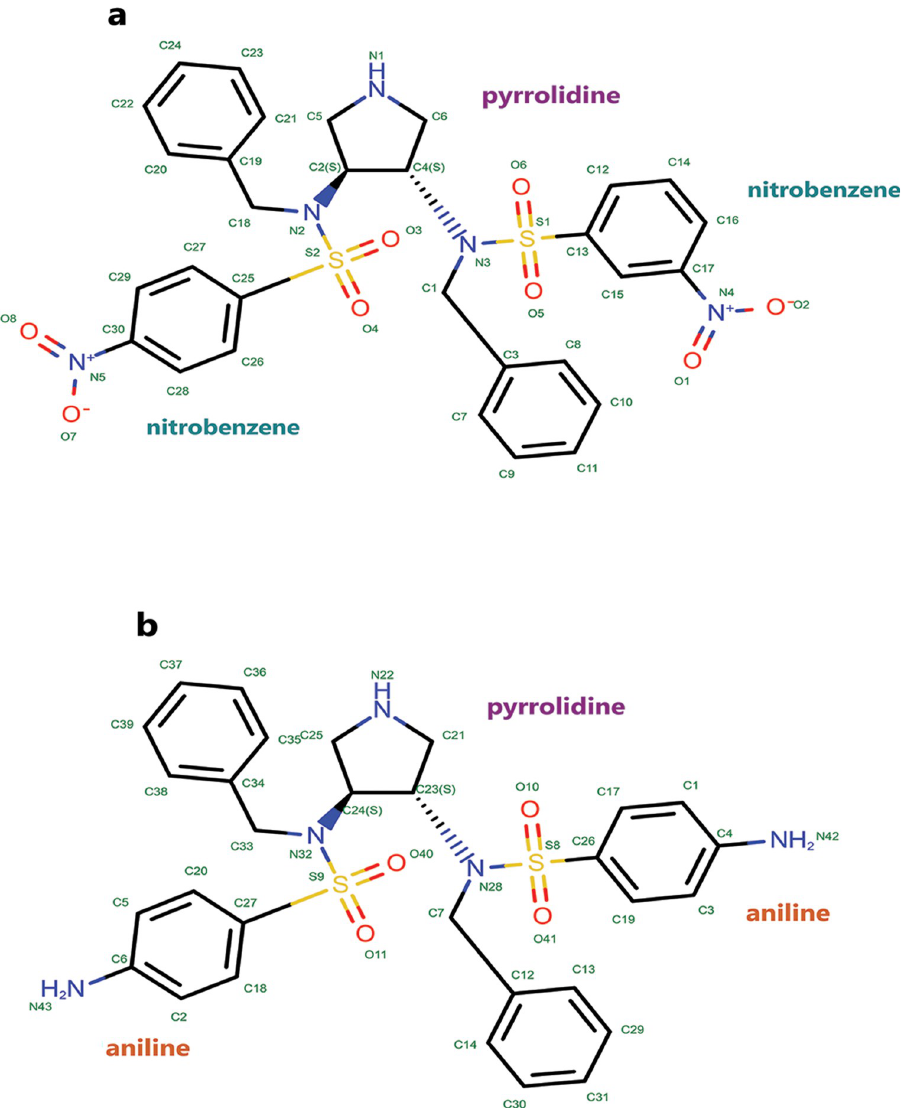
Fig 1. The 2D structures of selected compounds were obtained from PDB. A , Compound 9, the inhibitor in (PDB ID 4YDF). B , Compound 10, the inhibitor in (PDB ID 4YDG).